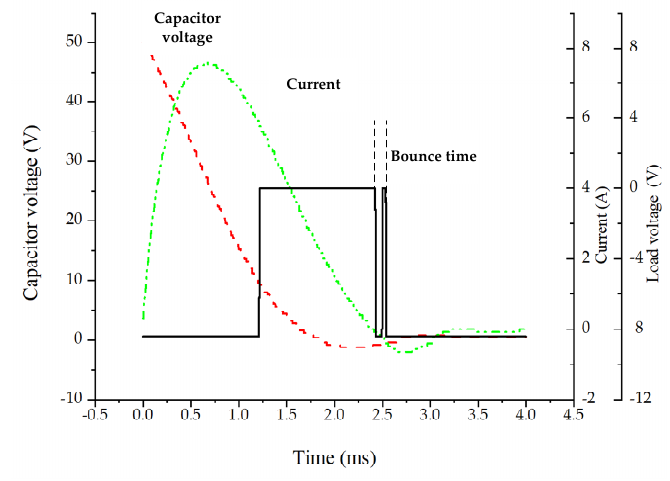
Figure 11. Low load switching waveform.